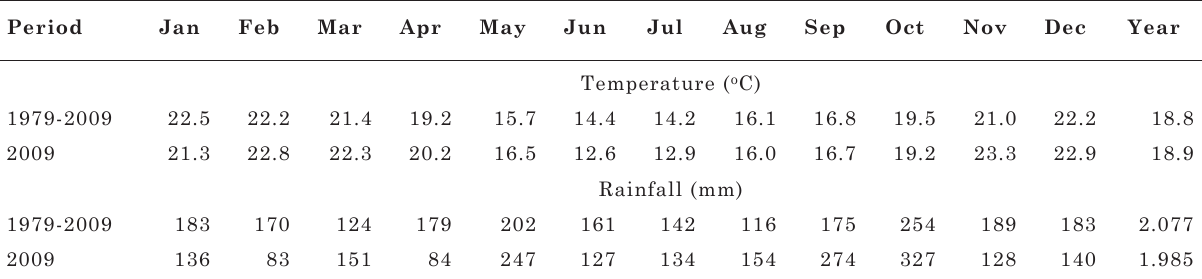
table 2. mean temperature and rainfall in an experimental area in Pato Branco, southeastern region of Paraná, averaged over 1979-2009 and in 2009 Period